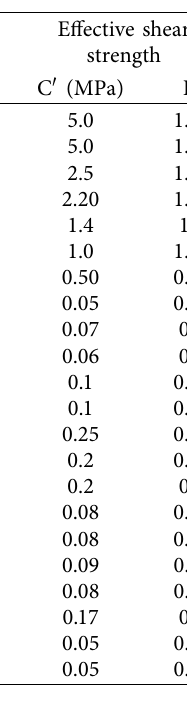
Table 2: Material mechanical parameters of Xiluodu arch dam.